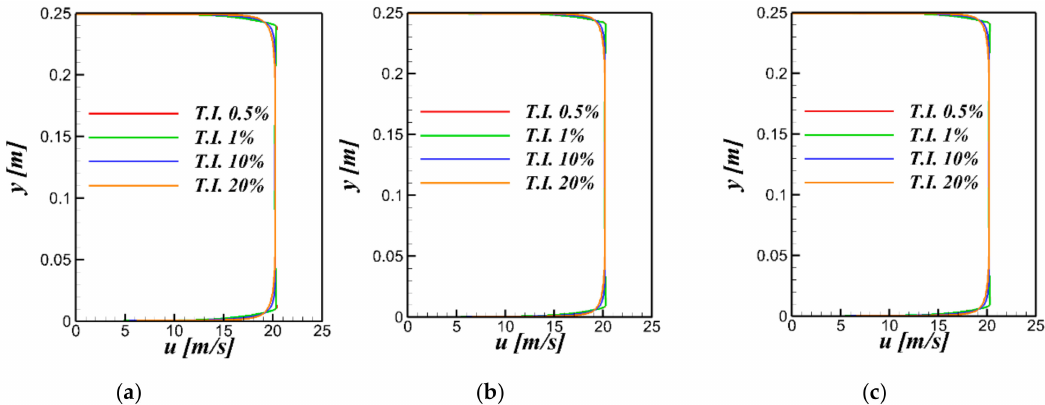
Figure 3. Velocity profile of various TI for the temperature; ( a ) 25, ( b ) 100, ( c ) 200 ◦